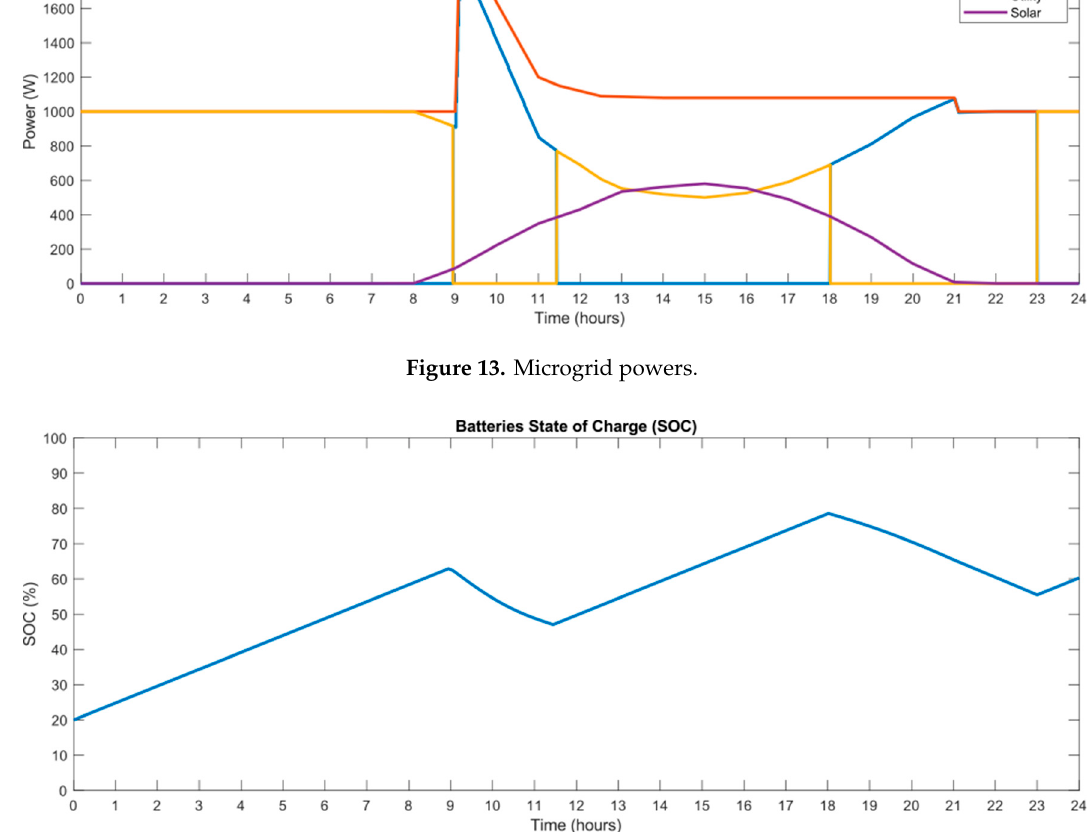
Figure 14. State of charge of batteries.